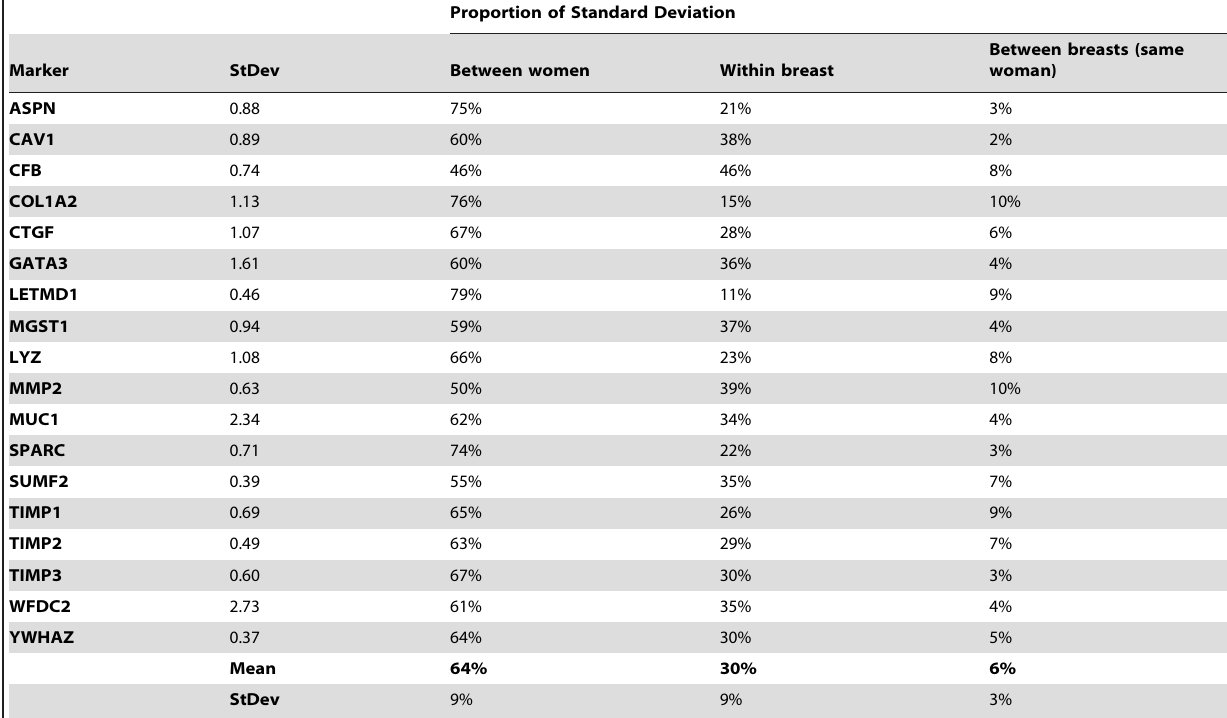
Table 1. Variability in gene